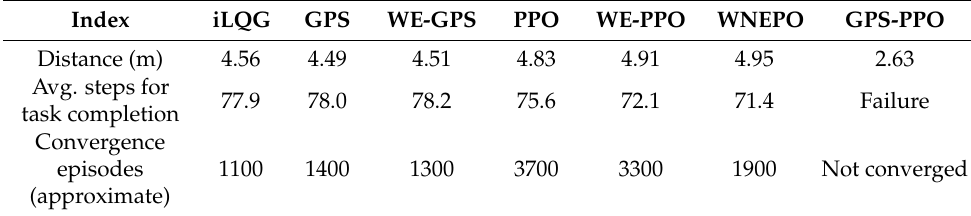
Table 3. Comparison of asymptotic performance and sample